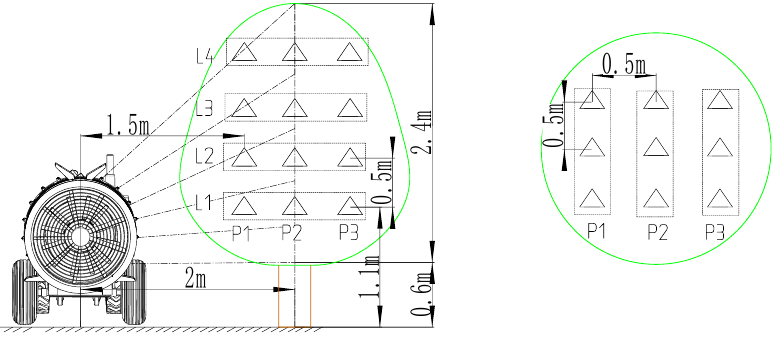
Figure 9. Distribution of the 36 points.